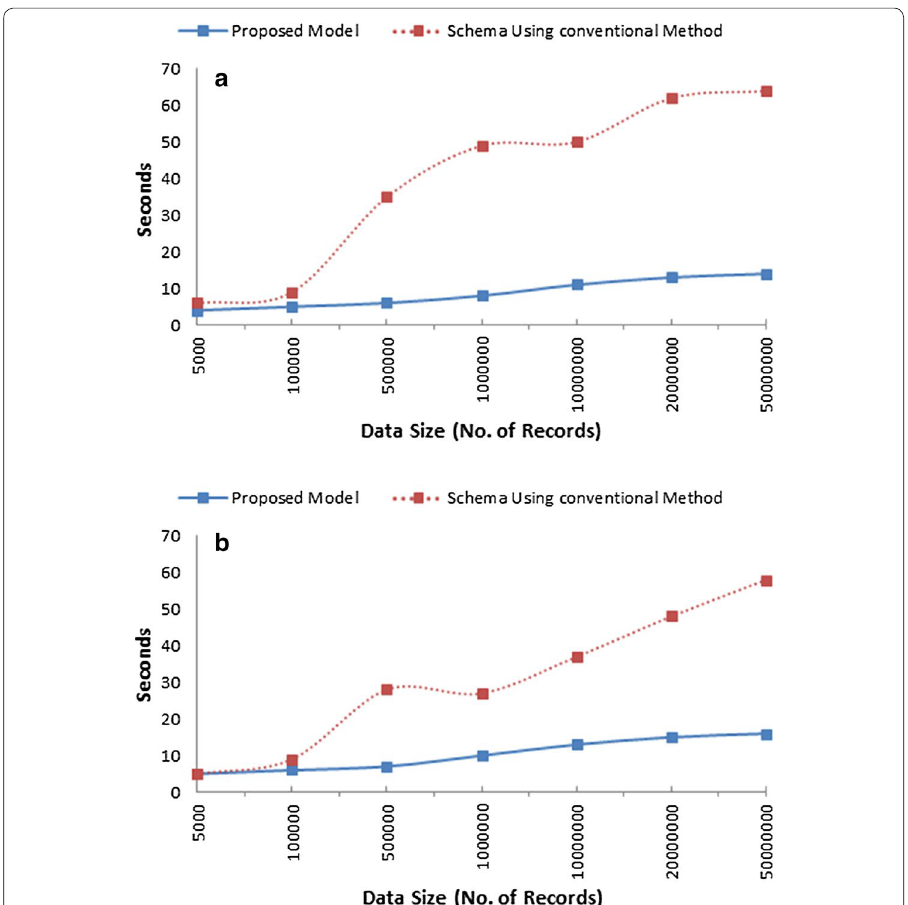
Fig. 3 Rate of record creations C : a performance comparison between schemas produced using the proposed model and conventional